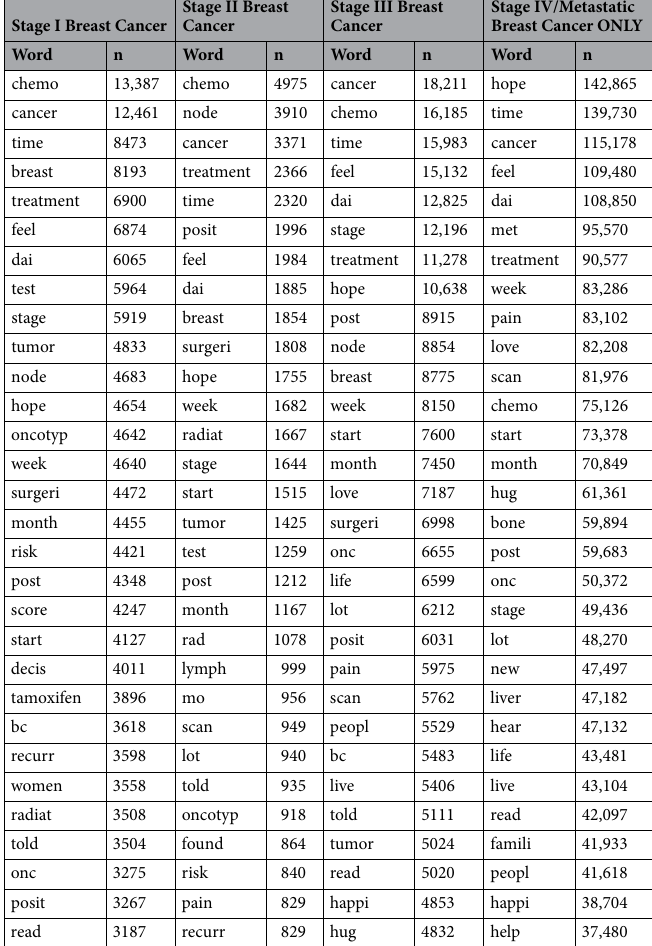
Table 4. Top 30 words based on the frequency of use in each